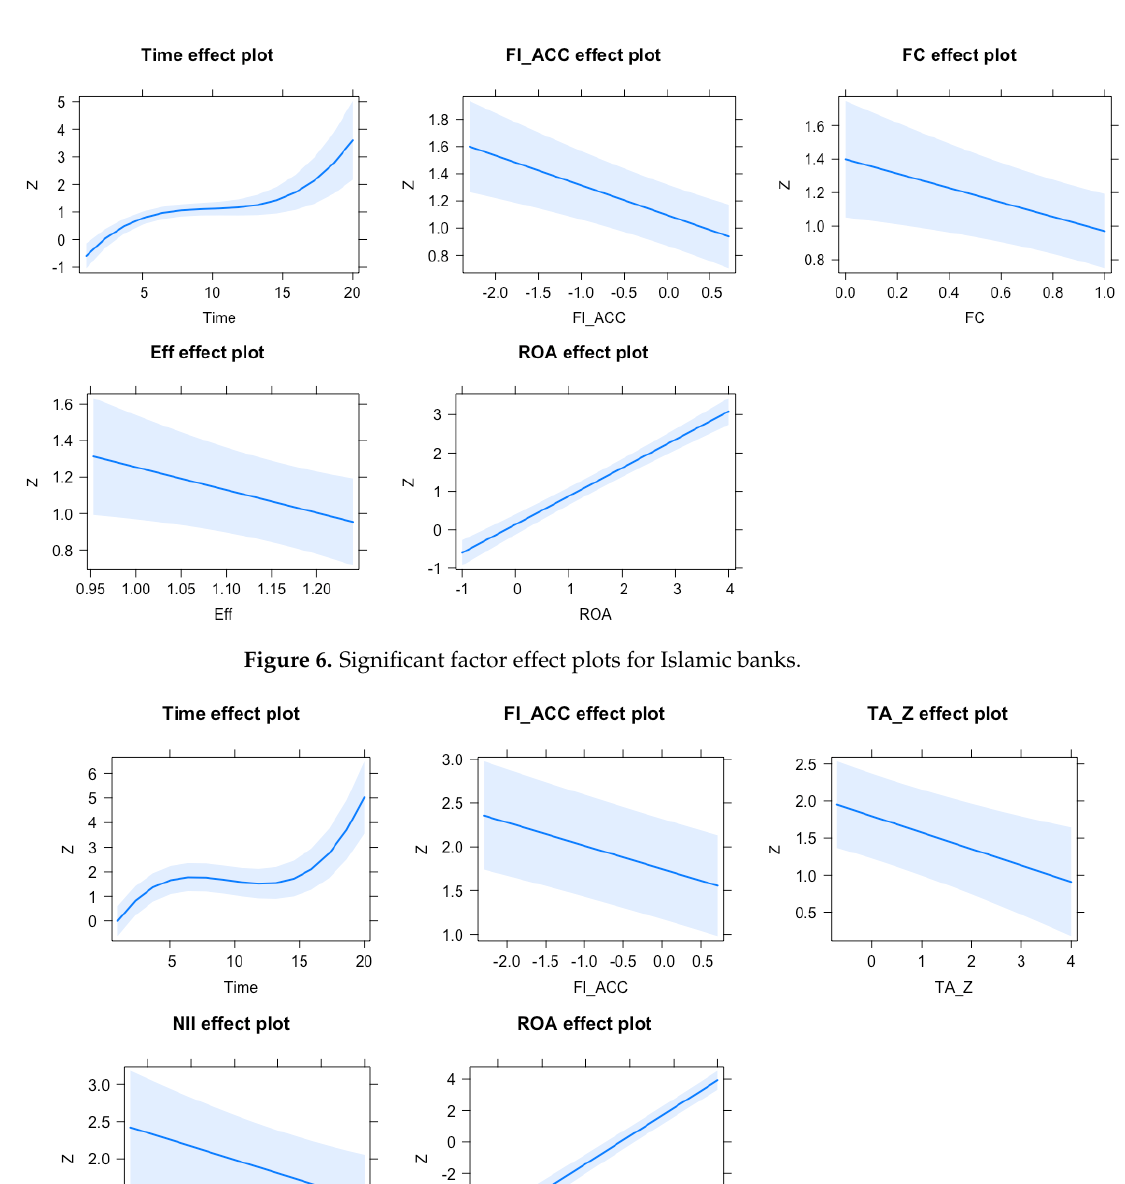
Figure 5. Significant factor effect plots for all banks.